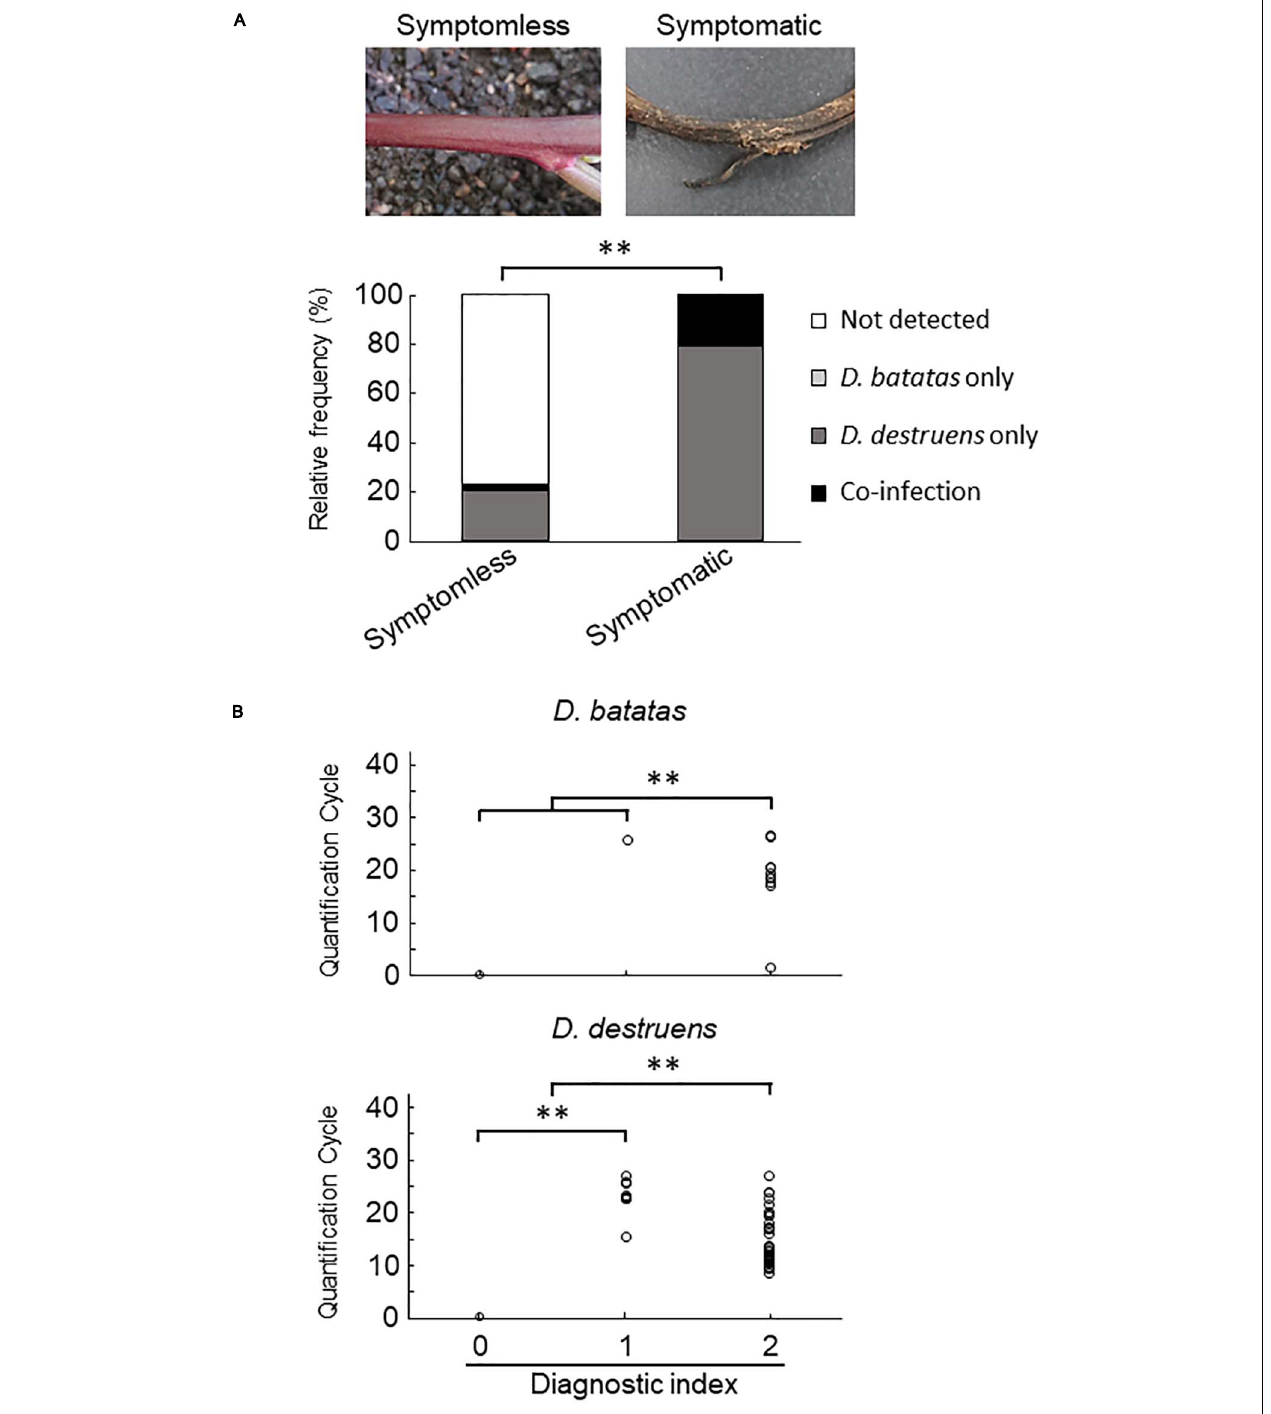
FIGURE 4 | Frequency of amplification of D. batatas and D. destruens DNA from naturally infected sweet potato stems. (A) Relative frequency of D. batatas and D. destruens detection in sweet potato stems with or without symptomatic disorder. The relative frequency of detection of the two pathogens was significantly different between symptomless and symptomatic stem tissues ( n = 77, ∗∗ P < 0.01, Fisher’s exact test). (B) Real-time PCR detection of D. batatas and D. destruens DNA from naturally infected sweet potato seedlings in the field. Quantification cycle using the new primers is graphed against diagnostic index of stem (0, symptomless with no pathogen detected; 1, symptomless but pathogen detected; and 2, symptomatic disorder with pathogen detected). The concentrations of D. destruens and D. batatas in stems with diagnostic index 2 were significantly higher than in those with index 0 or 1, and the concentration of D. destruens in stems with diagnostic index 1 was significantly higher than in those with index 0 ( n = 77, ∗∗ P < 0.01, Steel–Dwass test).